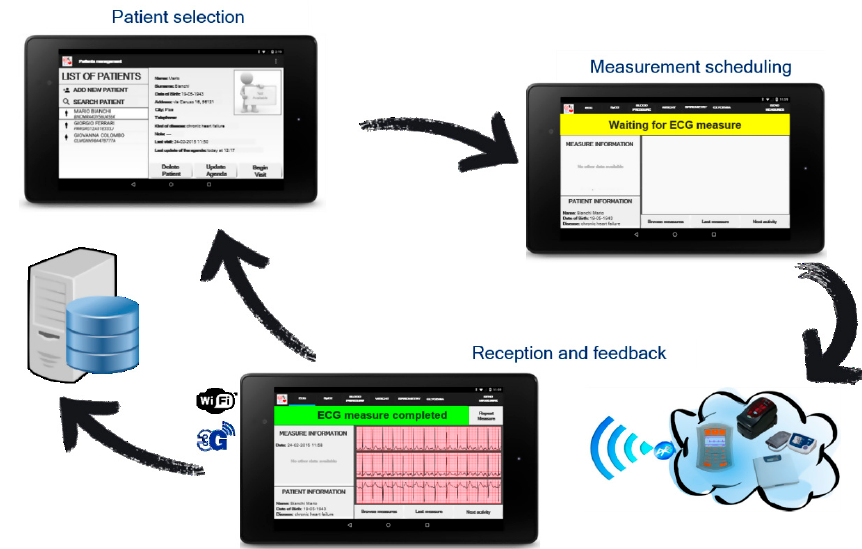
Figure 4. Example of Electrocardiography (ECG) acquisition and transmission with the professional- oriented gateway.